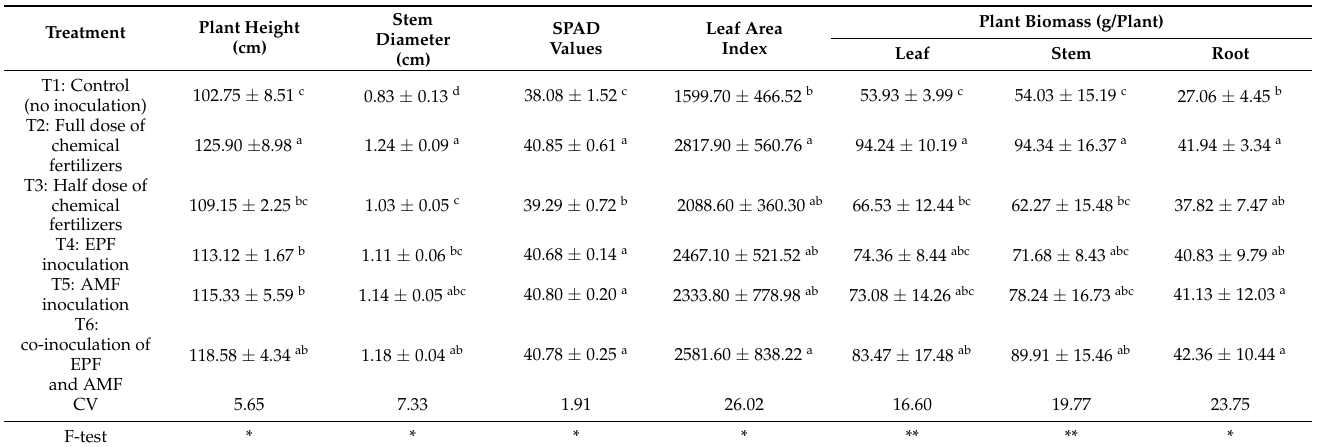
Table 2. Plant growth parameters of sunchoke including plant height, stem diameter, SPAD chlorophyll values, leaf area, and plant biomass (leaf, stem, and root) at 90 days after planting under field conditions.